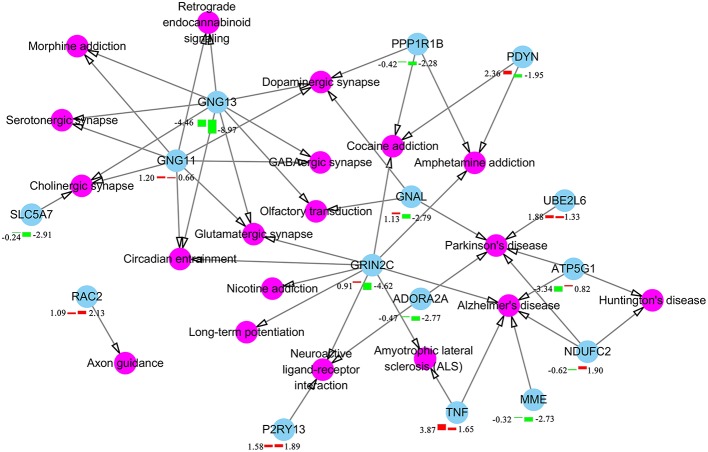
Differentially expressed components of neuron signaling pathways in T. gondii infected brain. Pink color represents neuron signaling pathway and cyan color represents the differentially expressed transcripts in brain at 6 or 18 dpi. The bars underneath the nodes represent the change in the expression level (left and right bars represent expressional changes at 6 and 18 dpi, respectively). Upregulated and downregulated transcripts are represented by red and green colors, respectively. The log2 fold-change of transcripts are described together with the bars.